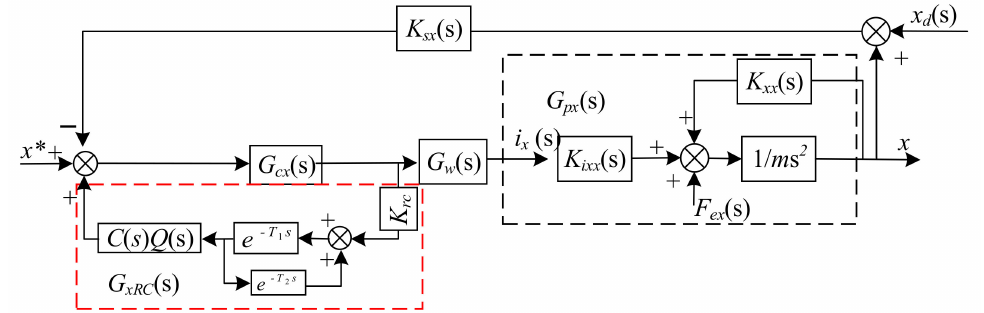
Figure 7. Control schematic diagram in x -direction with